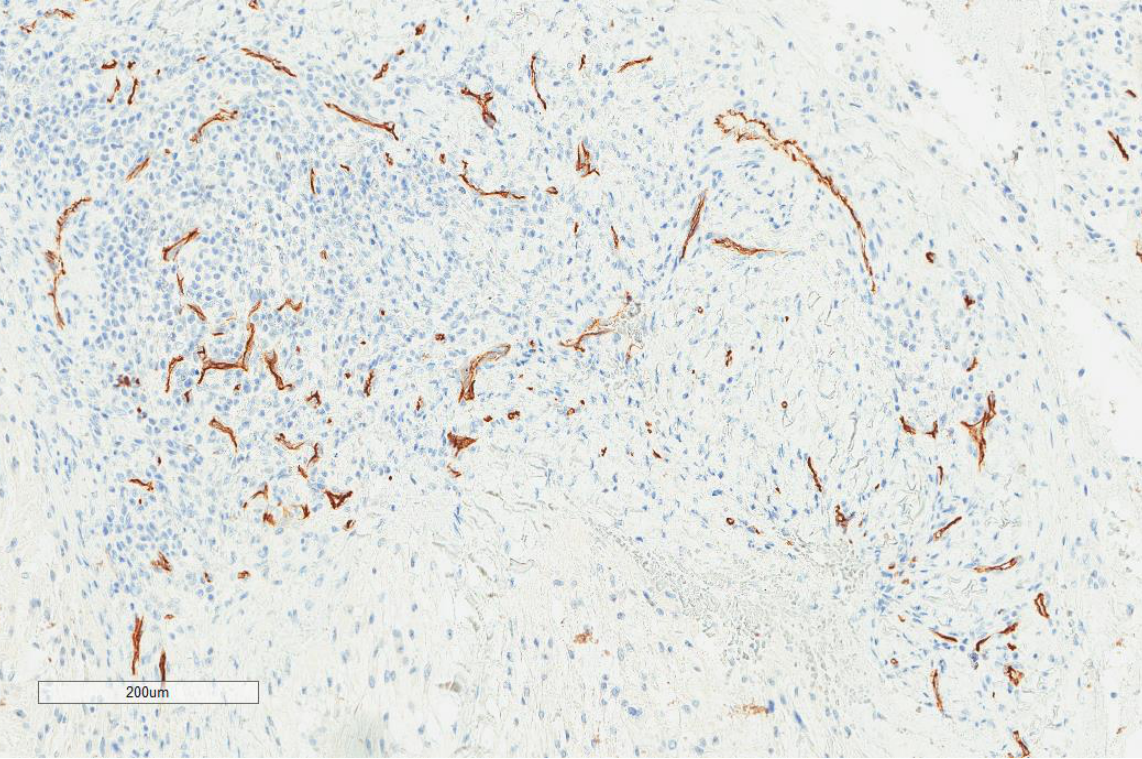
Figure 13. Representative image of CD34 vascular density (×100).